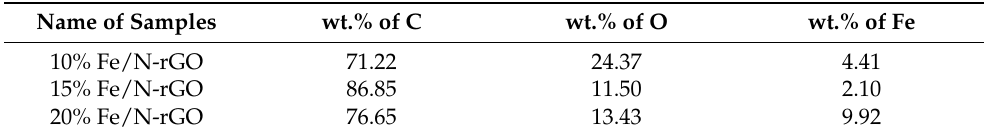
Table 1. Energy dispersive spectroscopy (EDS) results presenting the elemental composition of X Fe/N-rGO (X = 10%, 15% and 20%).